Question: Give a one-sentence summary of this figure.
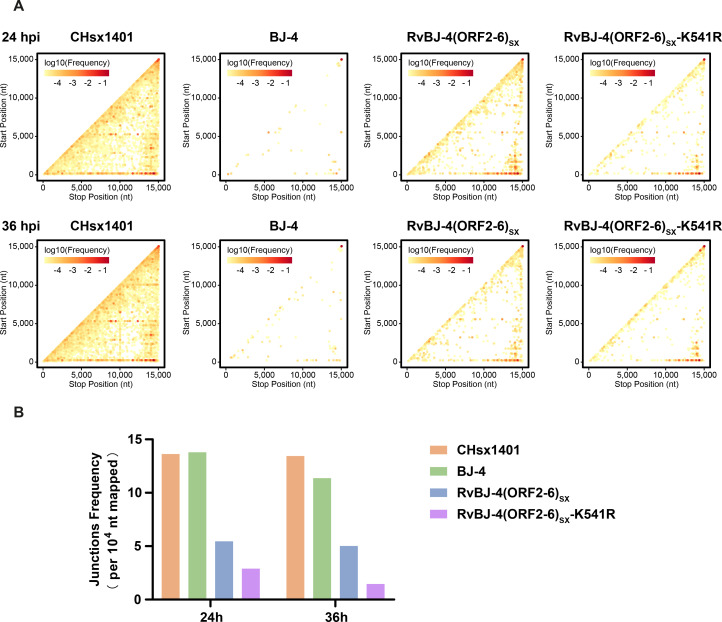
Answer: Analysis of intra-strain recombination events. ( A ) Scatter plots of recombination junctions at 24 and 36 hpi. The x -axis represents the genomic position of the donor site (5′ end), and the y -axis represents the acceptor site (3′ end). Reverse recombination signals were filtered out. Axes represent nucleotide start and stop positions. Off-diagonal signals indicate potential recombination events. Each spot is colored according to its frequency relative to the total population of junctions, transitioning from light yellow (lowest) to deep red (highest). ( B ) Normalized intra-strain recombination junction frequency. Data are expressed as the number of junction reads per 10 4 mapped nucleotides derived from NGS analysis.